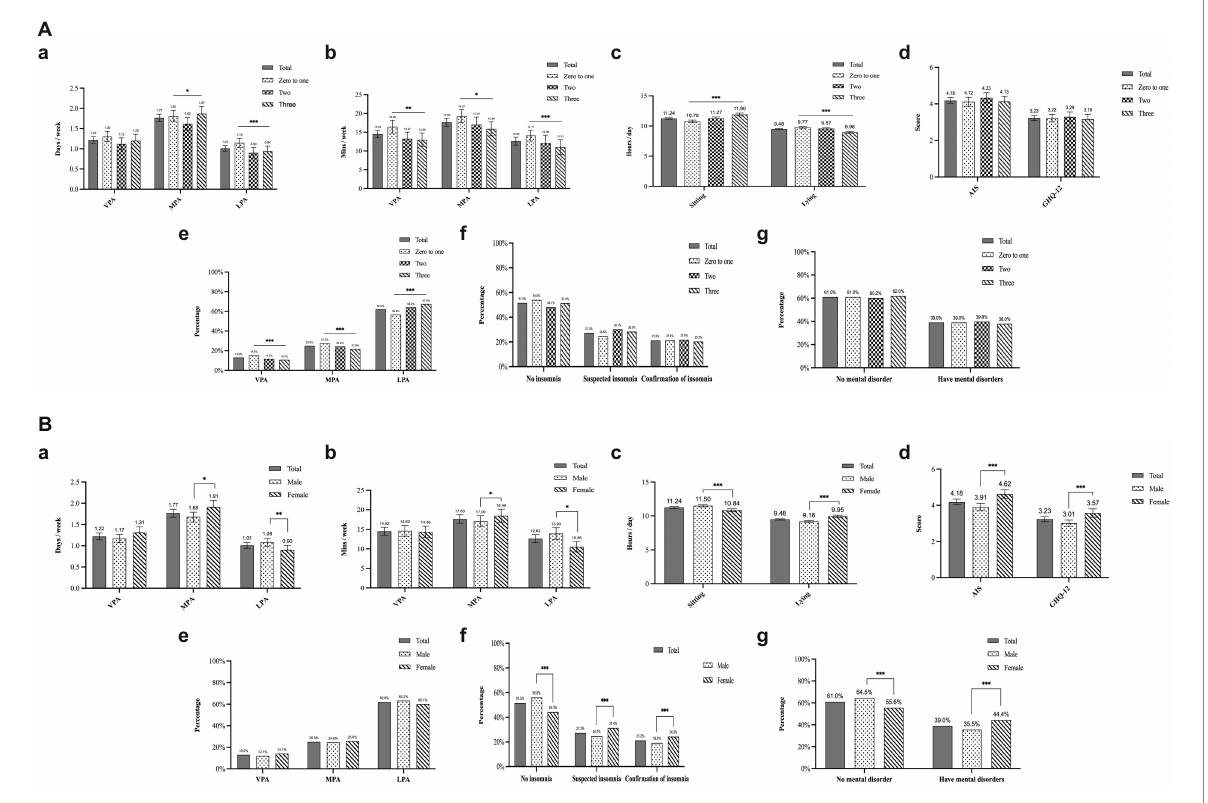
FIGURE 2 (A) PA behavior, sleep disorder, and mental health during the lockdown among different living conditions. * p < 0.05, ** p < 0.01, *** p < 0.001. (B) PA behavior, sleep disorder, and mental health during the lockdown among gender. * p < 0.05, ** p < 0.01, *** p <